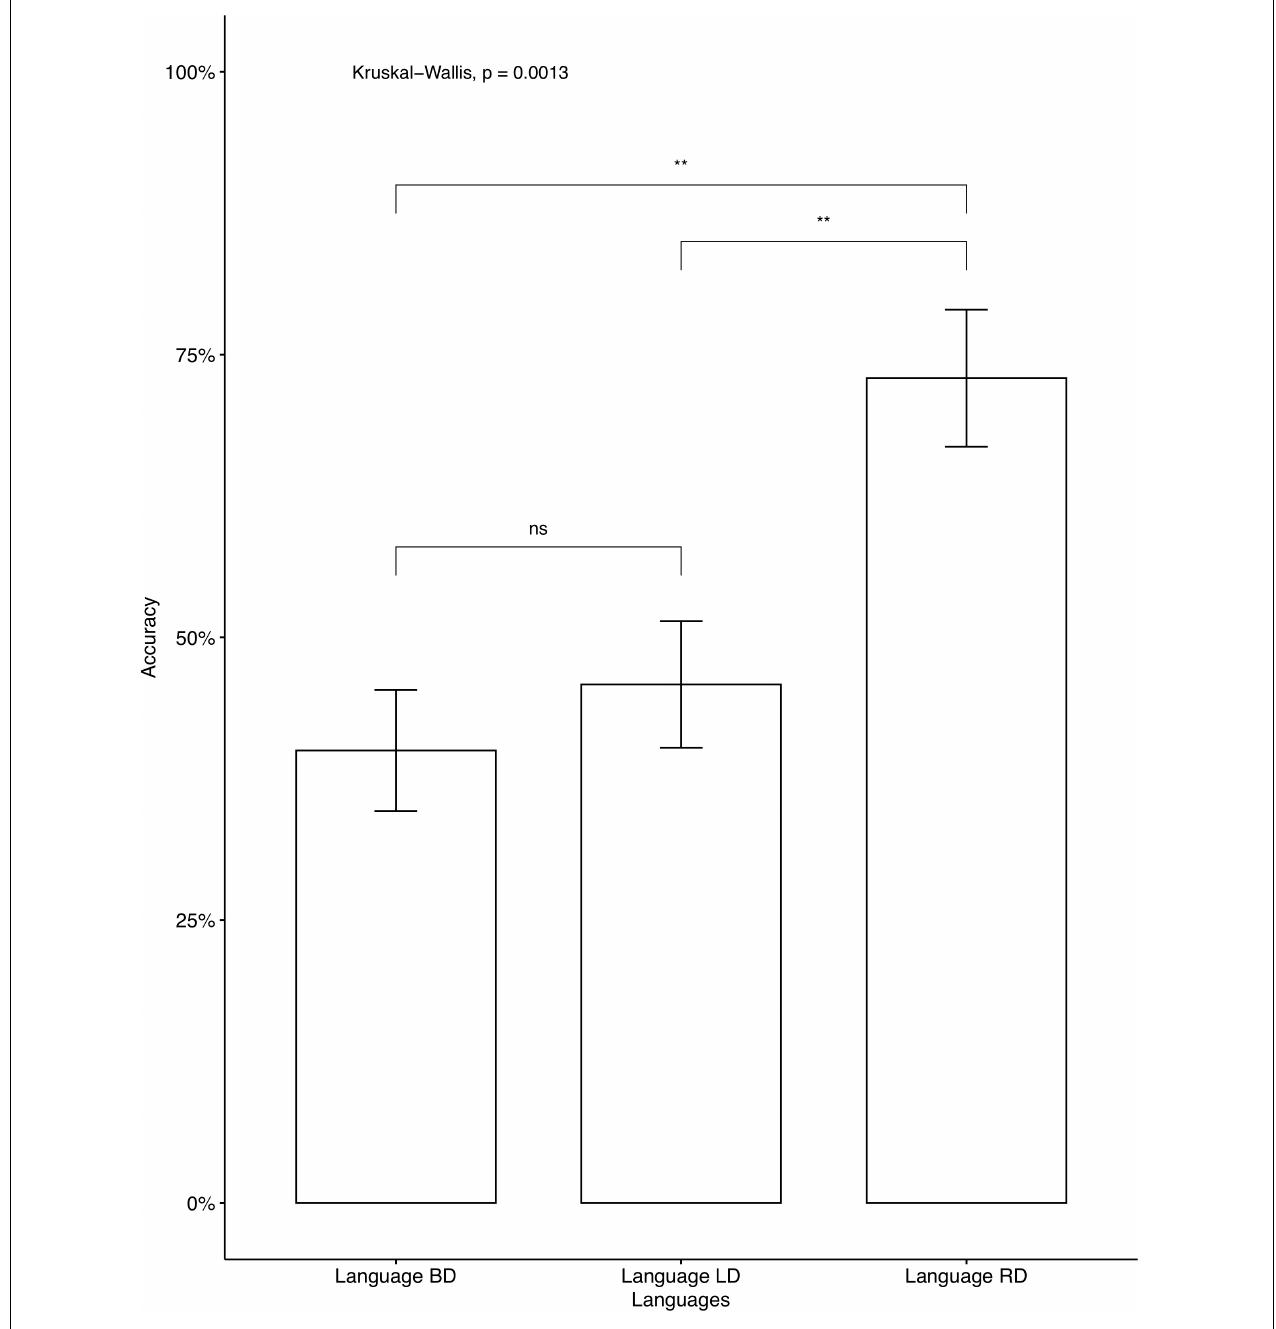
FIGURE 3 | Accuracy on critical unseen items: Mandarin native speakers. The 95% confidence interval is specified for each bar. **indicates significant mean difference, p < 0.01.